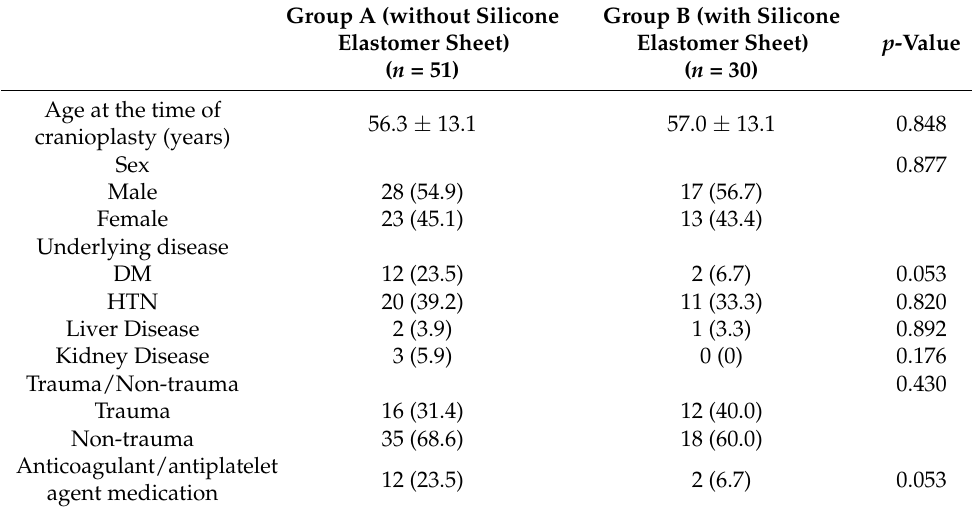
Table 1. The baseline characteristics of patients in the two groups.